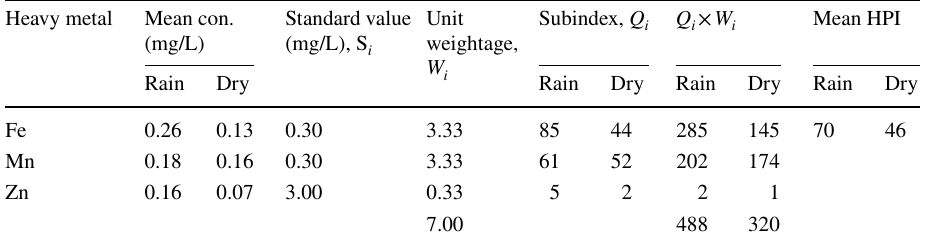
Fig. 4 HPI values of individual sampling stations compared to heavy metal pollution on the threshold risk (HPI =